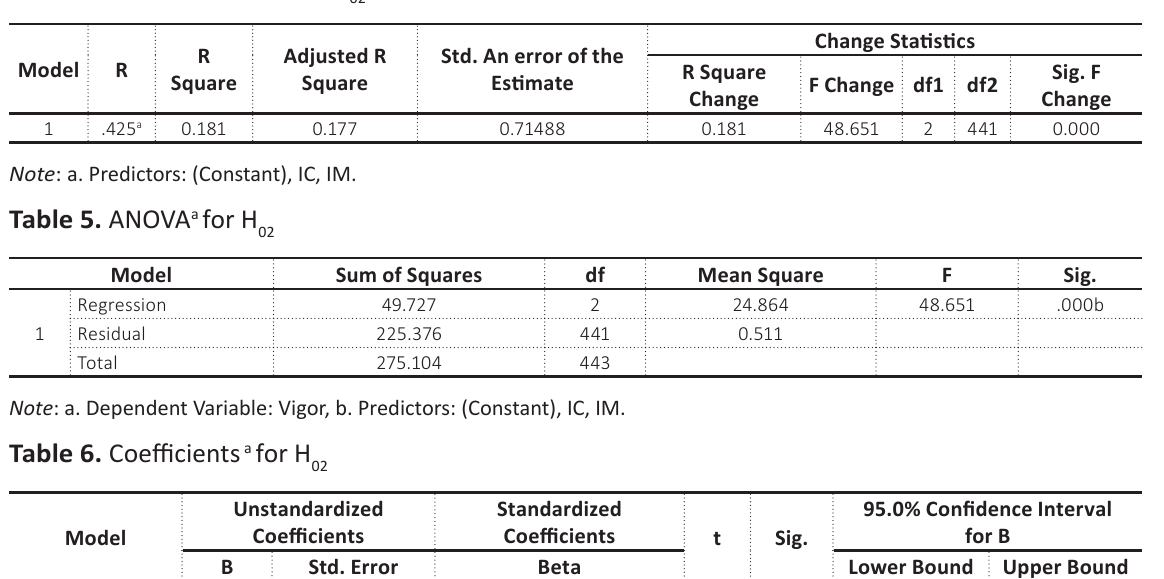
Table 4. Model summary for H